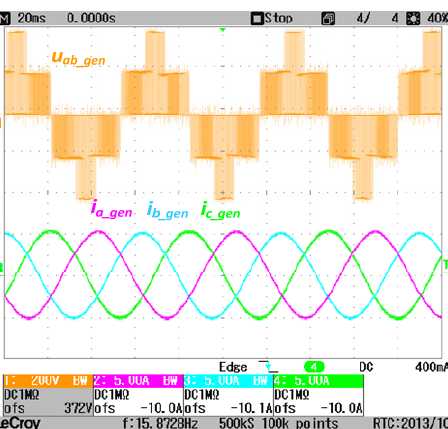
Fig. 14. Steady state of AC-DC part of converter. From top: phase to phase voltage of converter ( u ab_gen ) and generator phase currents ( i a_gen , i b_gen , i c_gen ).